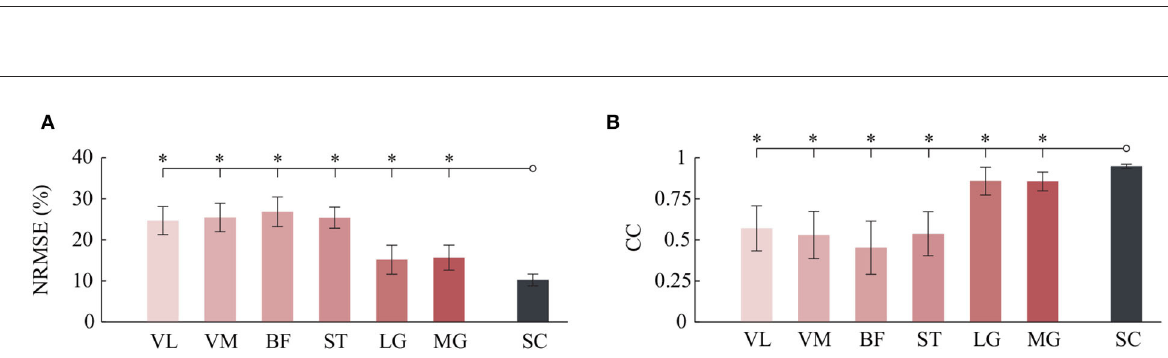
FIGURE4 Comparison of angle estimation accuracy between six kinds of single-channel sEMG and six-channel sEMG (SC). (A) Comparison of NRMSE. (B) Comparison of CC. Bars are means, error bars are standard error of the mean (SEM), and asterisks denote statistically significant differences with respect to the six-channel sEMG ( P <